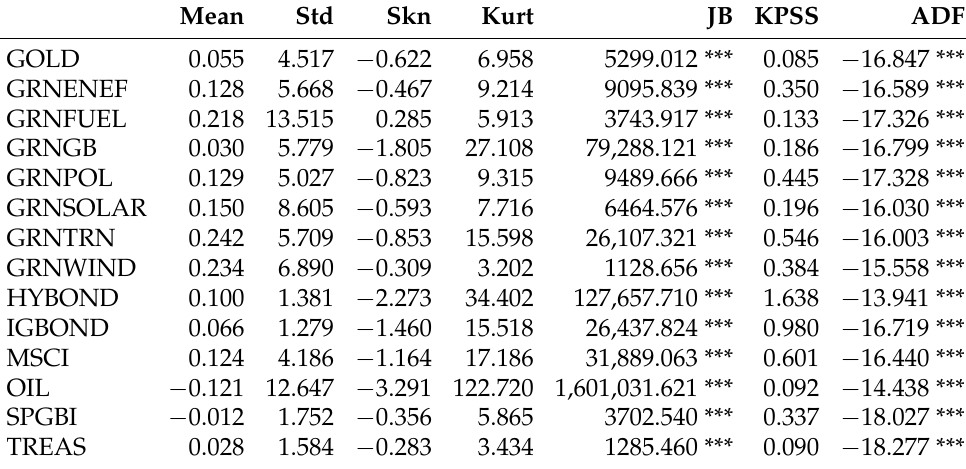
Table 1. Descriptive statistics of the data. This table presents the descriptive statistics and unit root test results of daily returns of green bonds and green stocks and the group of conventional asset classes considered for the whole sample period. JB denotes the J-B test statistic for the null of normality. In turn, ADF and KPSS represent the statistics of the Augmented Dickey–Fuller (ADF) unit root test and Kwiatkowski–Phillips–Schmidt–Shin (KPSS) stationarity test, respectively. As usual, *** indicates statistical significance at the 1% level. Mean Std Skn Kurt